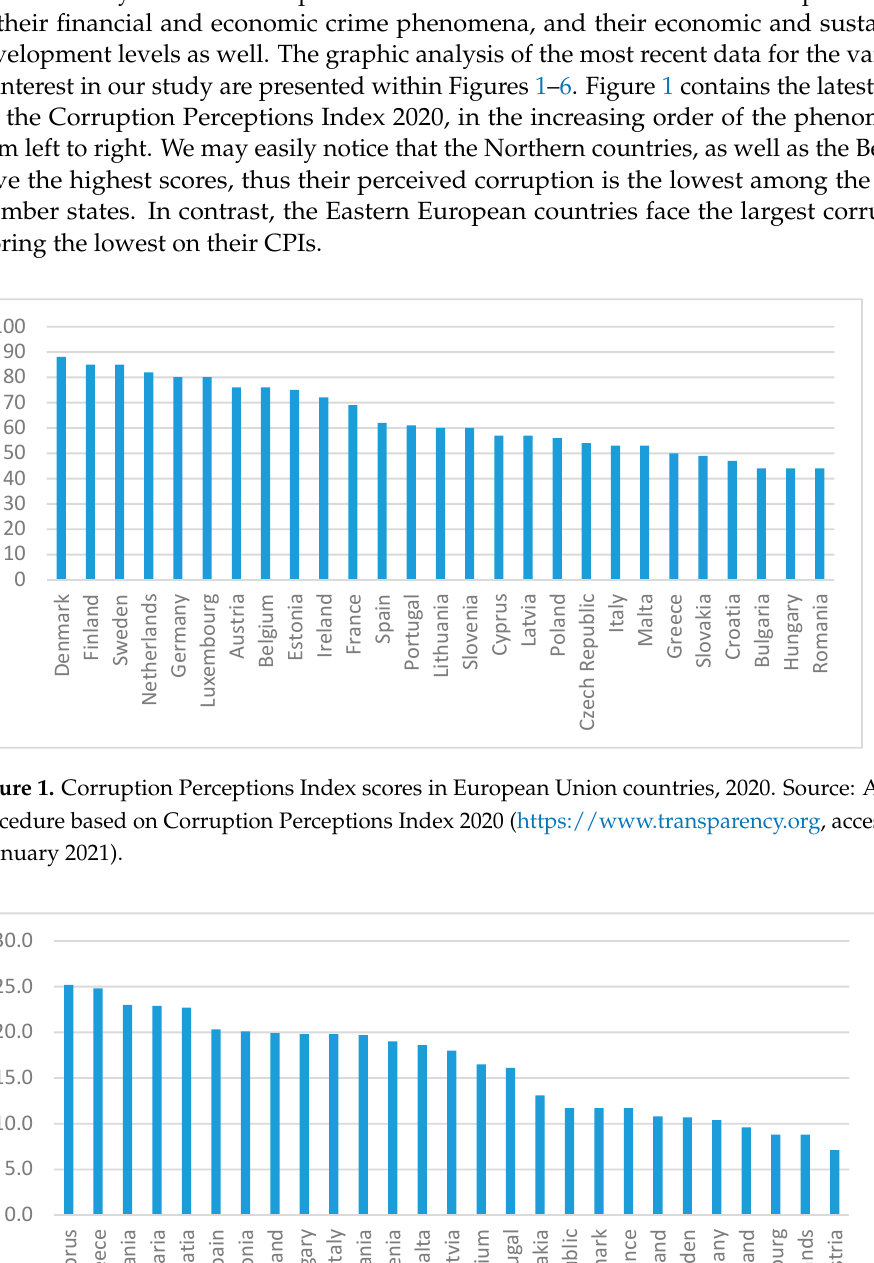
Figure 3. The risk of money laundering in European Union countries, 2020. Source: Authors’ pro- cedure based on data from Basel Institute of Governance (2020). Figure 4 represents the latest available Global Security Index, v3, at the date of writ- ing this paper. Western European countries score great, possessing low global security risks, while most Eastern European countries register low Global Security Indexes, plac- ing their transactions at greater risk.